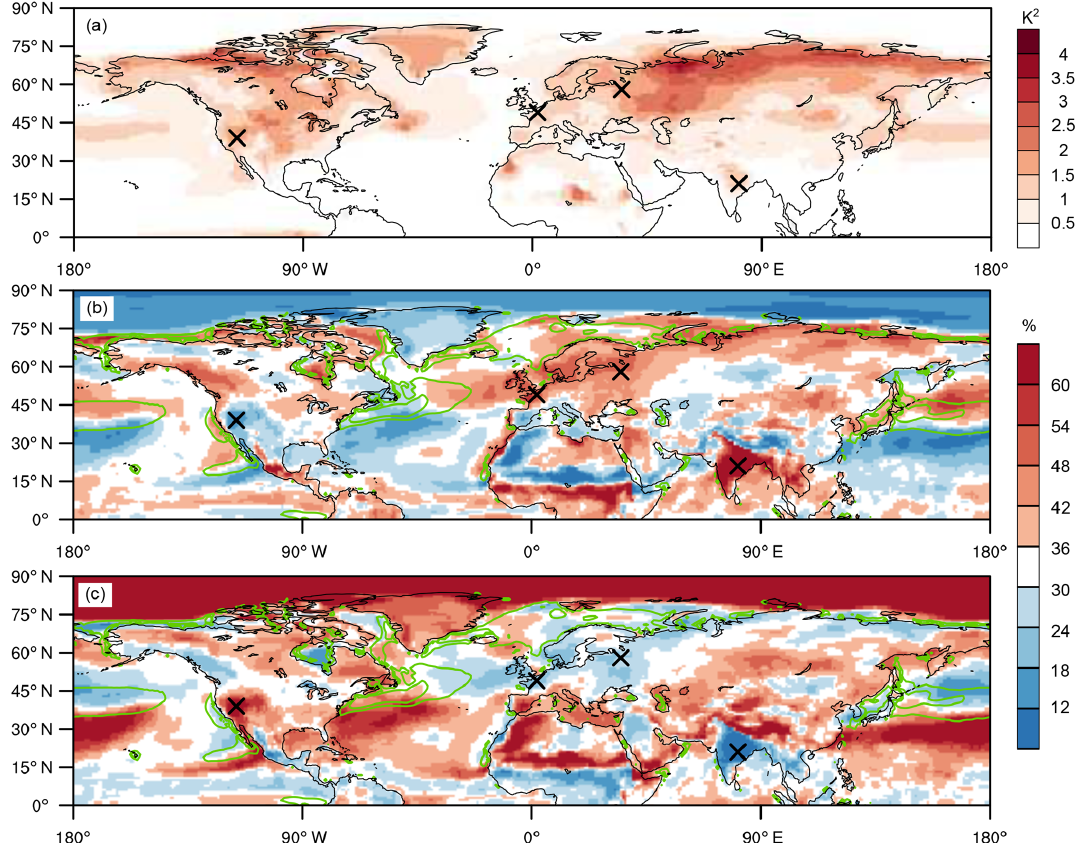
Figure 6. The variance of RDA ERAI and its contributions from the coldest and hottest third of summer days. Panel (a) depicts V ERAI , and d,k panels (b) and (c) show VF ERAI and VF ERAI , respectively. Green contours in panels (b) and (c) depict C ERAI gradient magnitudes of 6 and hot cold 12K10 − 6 m − 1 . The C ERAI gradient magnitudes have been computed as first-order central differences and are only plotted over oceans. Black crosses as in Fig.